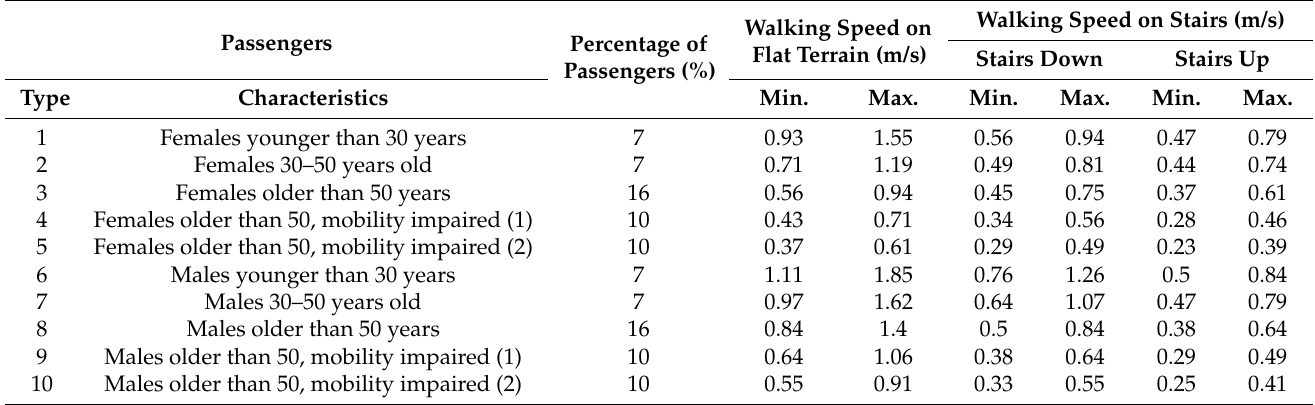
Table 2. The percentage and walking speed of